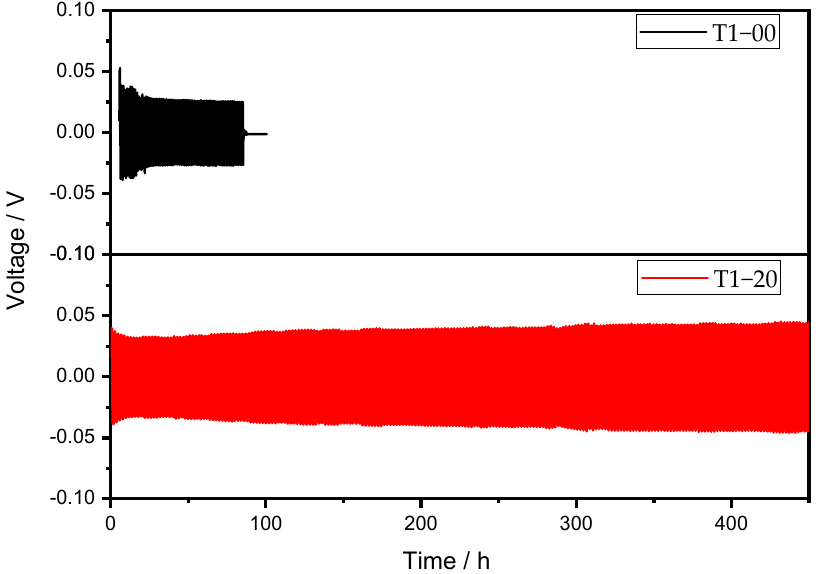
Polymers 2021 , 13 , x FOR PEER REVIEW